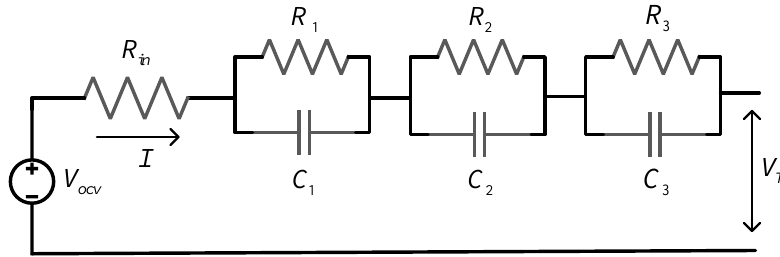
Figure 1. Third-order equivalent circuit battery